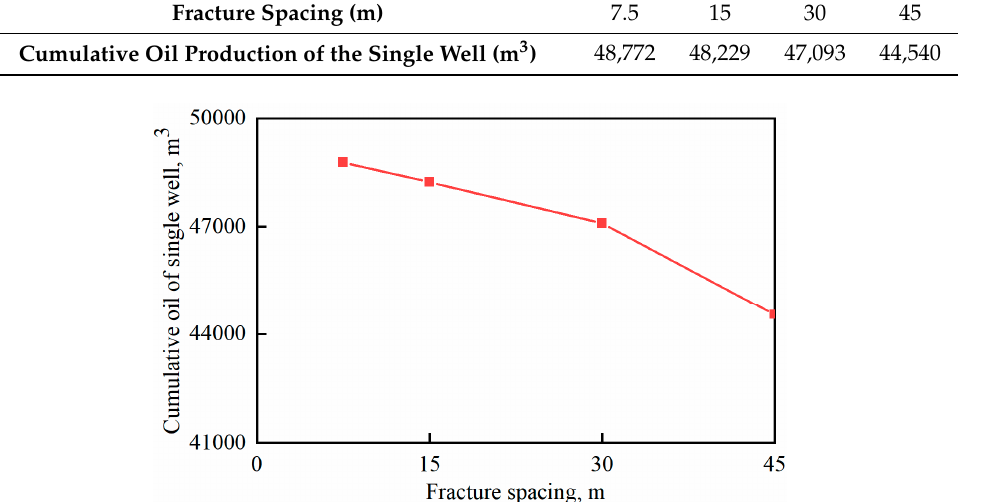
Figure 20. The relationship between cumulative oil production and fracture spacing in the single well.